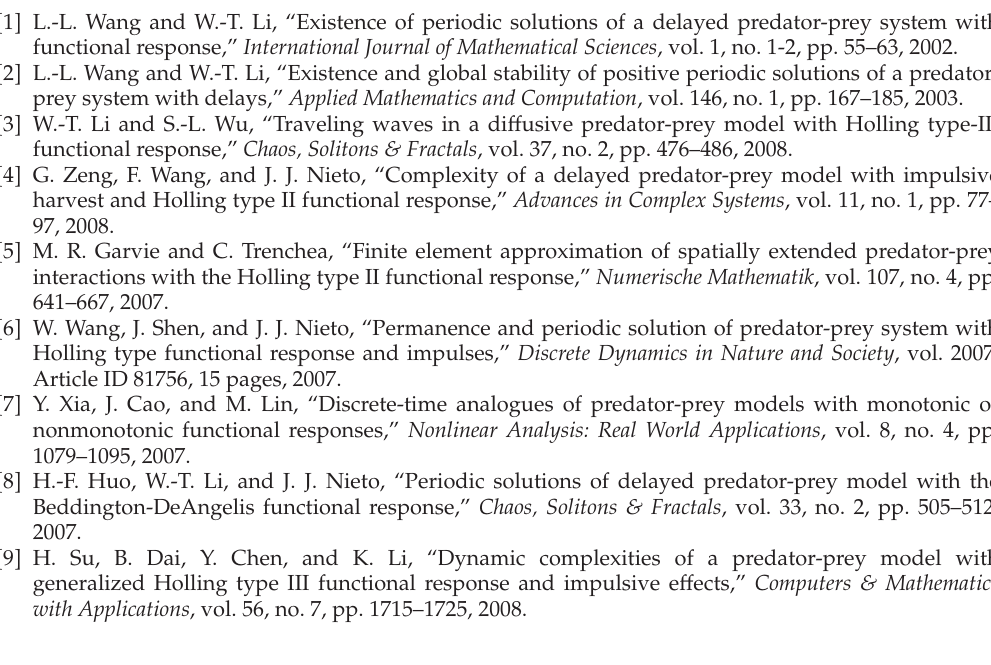
Thus, condition (cid:6) H 7 (cid:7) is satisfied; from Theorem 4.1, it follows that lim n → (cid:9) ∞ y (cid:6) n (cid:7) (cid:8) 0 . Numeric simulation (cid:6) Figure 2 (cid:7) strongly supports our